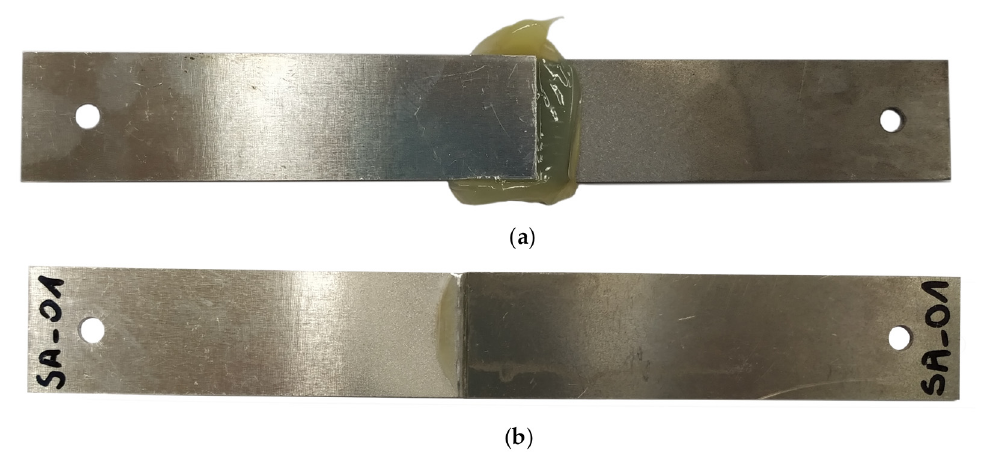
Figure 10. A single-lap specimen: ( a ) after being removed from the stand, ( b ) after removal of the adhesive scraps (test specimen).